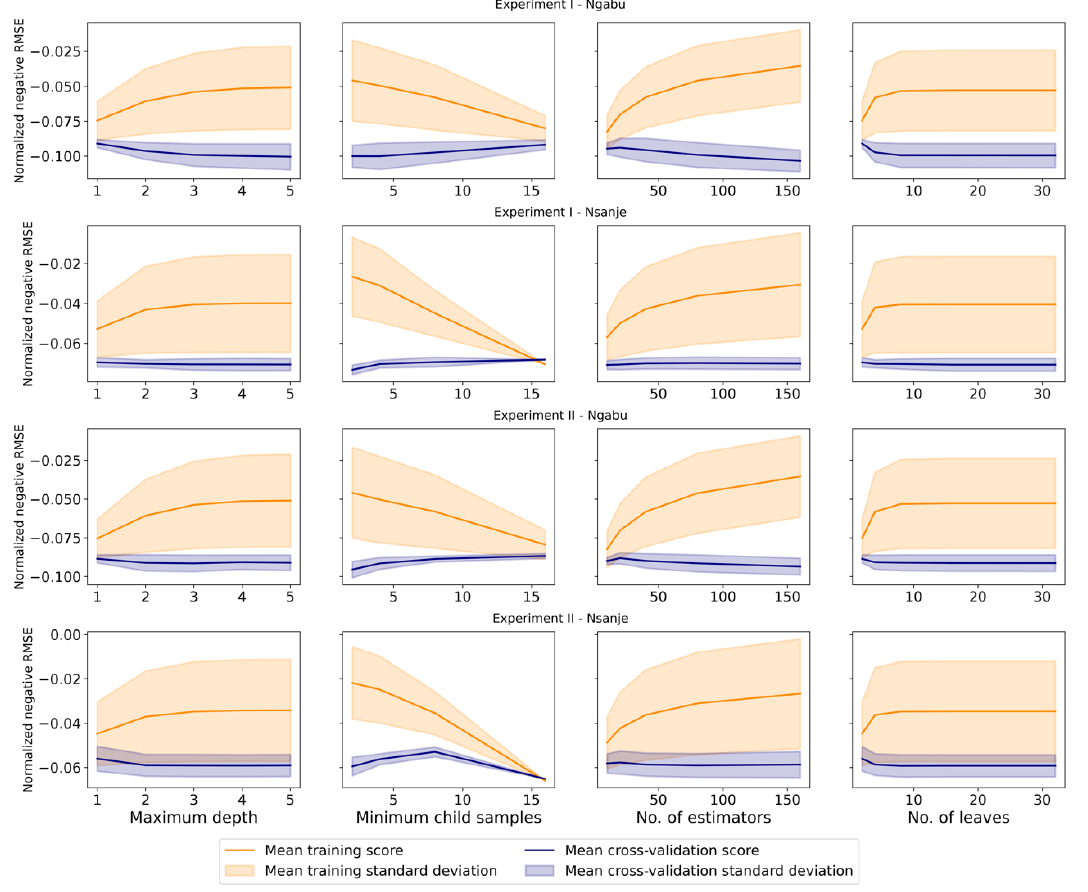
Figure 8. Plots of the cross-validation analysis results for each of the hyperparameters in the GBDT models across the various experiments. Note that the dimensions for error scores are returned as normalised negative RMSE values, which is simply the negated RMSE (i.e., unitless).